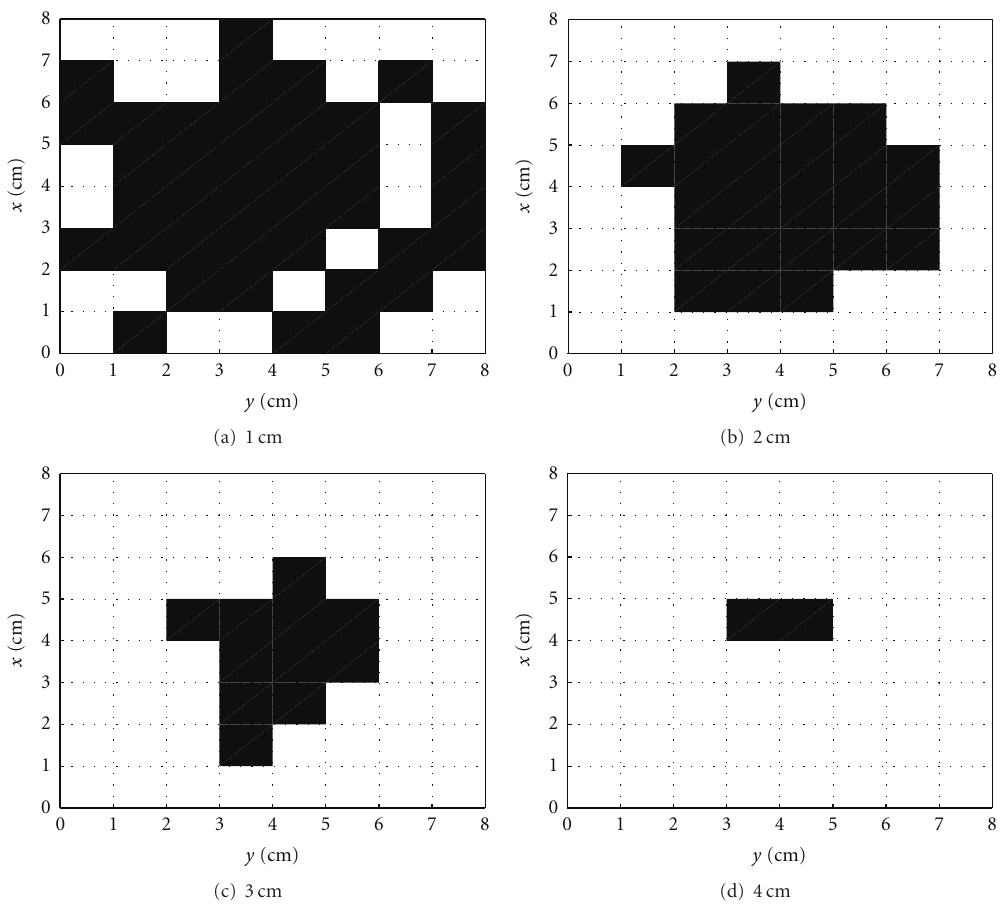
Figure 10: Measurement result of the interrogation